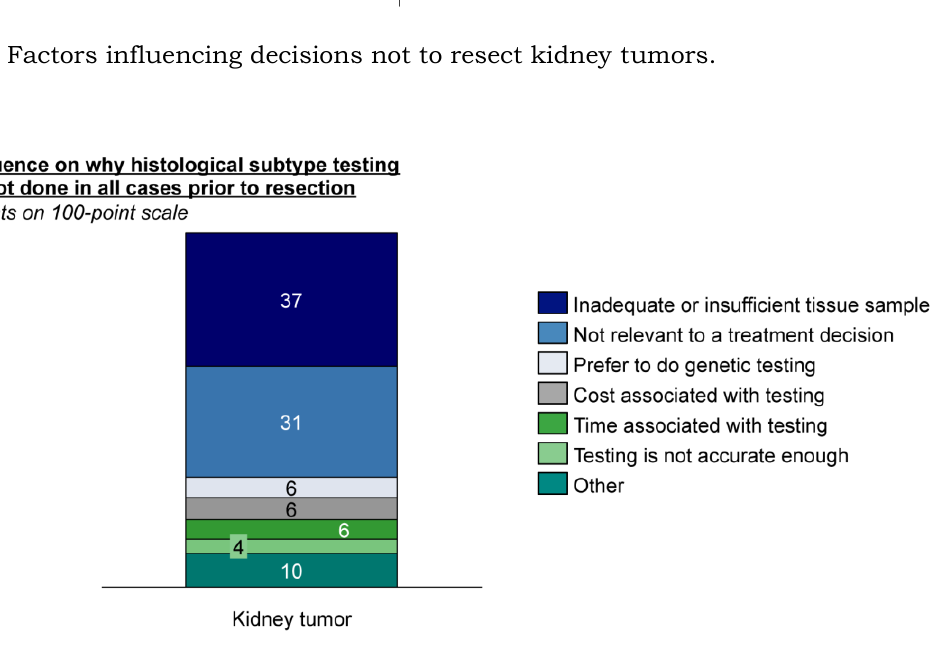
Figure 6. Pathologists’ rationale for not performing pre-op